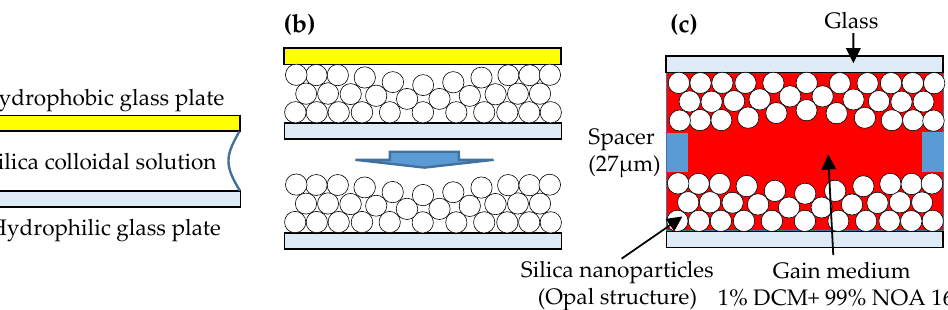
Figure 1. Sample fabrication of the colloidal-crystal laser: ( a ) the silica colloidal solution was placed between the hydrophobic and hydrophilic glass plates; ( b ) the silica colloidal particles were self-assembled into the opal structure; ( c ) two opal plates were combined and injected with the DCM-doped NOA 164 solution to finish the sample fabrication.